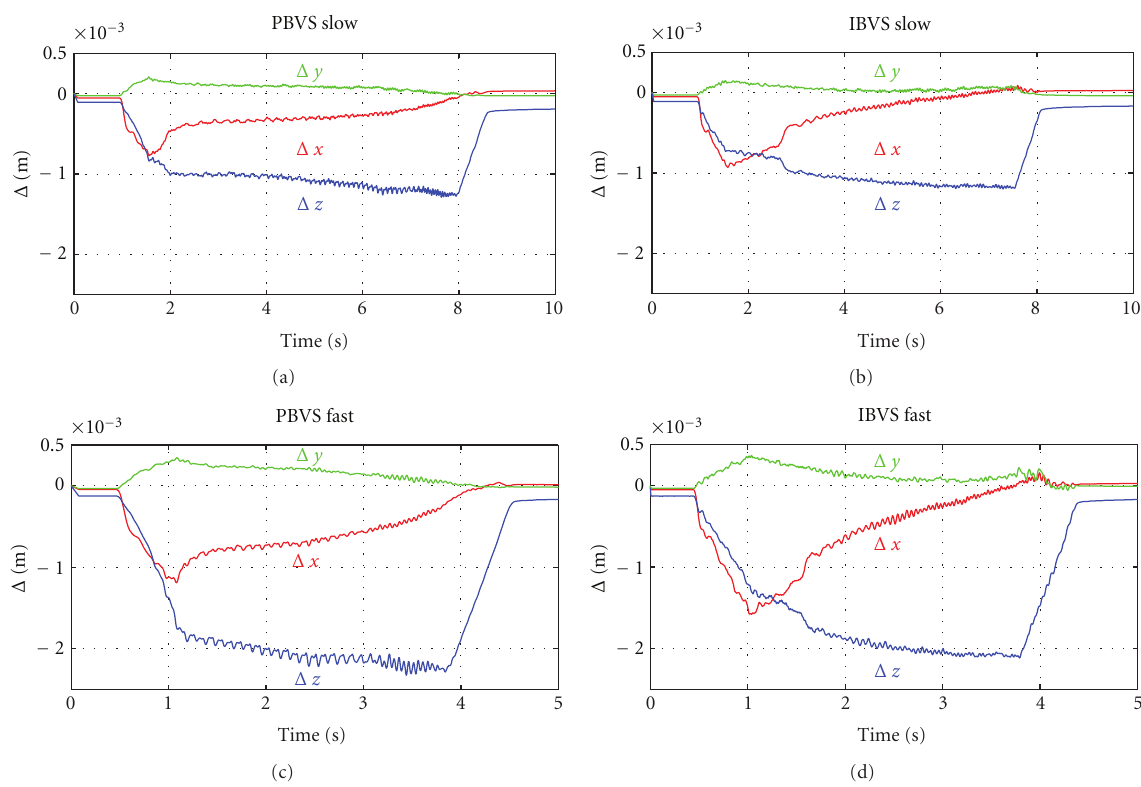
Figure 10: Errors between planned and measured Cartesian coordinates for PBVS and IBVS at slow and fast mode.